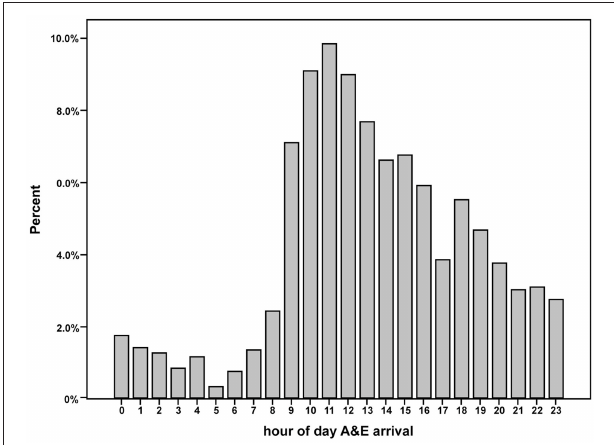
FIGURE 3 | Hourly admission numbers of patients with acute ischemic stroke treated with intravenous thrombolysis